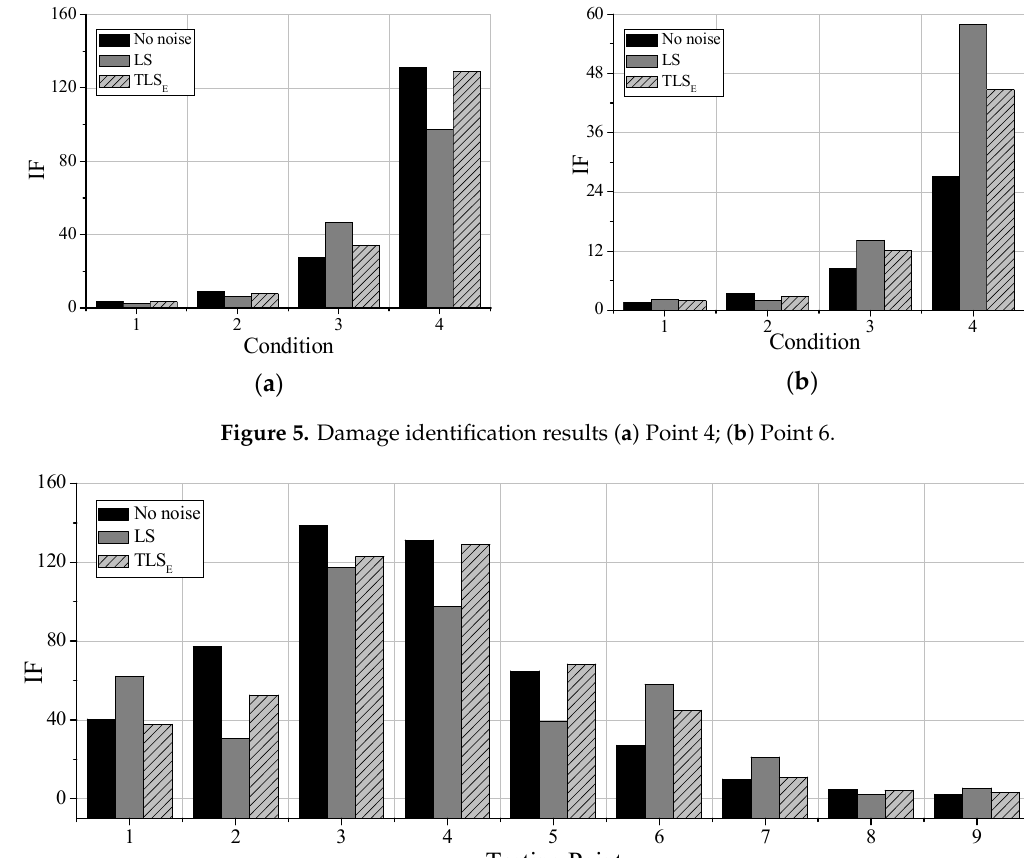
Figure 4 . Observed signal with 30 dB Noises: ( a ) Before damaged; ( b ) Condition 3.